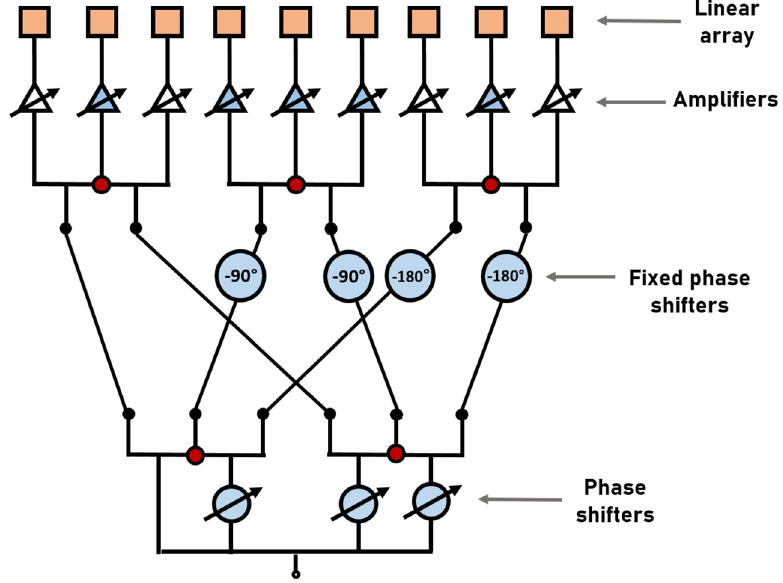
Figure 4. Scheme to illustrate the recombination nodes for the 4 × 9 CORPS network.